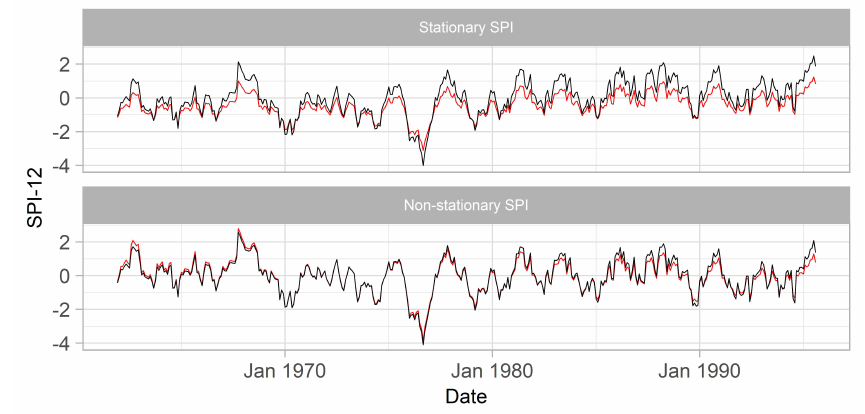
Figure 7. Comparison between Y ( 12 ) , ( k , l , m ) (red) and Y ( 12 ) , ( k ) (black) using Gamma and NSGamma probability density